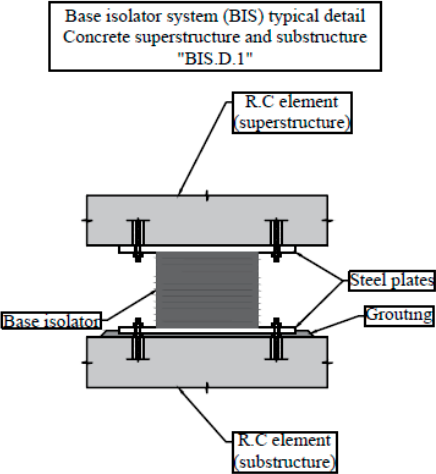
Figure 8. Base isolator system attachment to concrete superstructure and substructure—typical detail (after [20,32,33]).